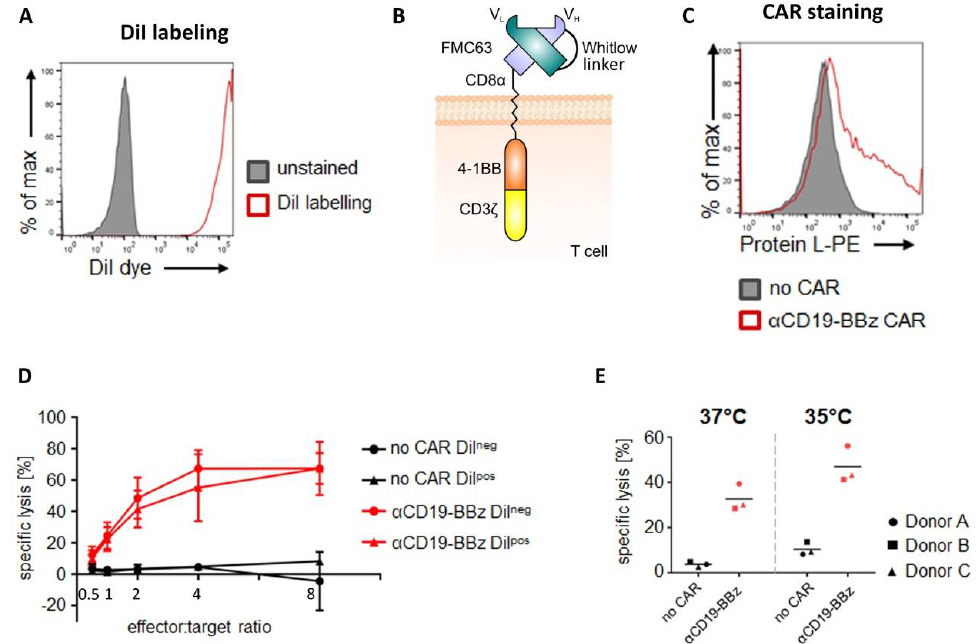
Figure 1. Chimeric antigen receptor (CAR) T cell mediated killing of Nalm-6 cells in vitro . ( A ) Efficacy of DiI-labeling in primary human T cells was analyzed by flow cytometry (excitation at 561 nm, detection with a 582/15 bandpass filter). Unlabeled T cells (“unstained”; filled grey histogram) served as a control. One representative experiment is shown. ( B ) Schematic of the CD19-specific second-generation CAR (FMC63.4-1BB.ζ) in which the FMC63-based scFv was fused to the hinge and transmembrane region of CD8α and the cytoplasmic domains of 4-1BB and CD3ζ. ( C ) Expression of the CD19-specific CAR in primary human T cells. Flow cytometric analysis using Protein L as a detection reagent. Mock T cells (“no CAR”; filled grey histogram) served as a negative control. One representative experiment of three independent experiments is shown. ( D ) Influence of DiI-labeling on the cytolytic activity of CAR T cells. Primary human T cells expressing either the CD19-specific CAR or no CAR and labeled or not labeled with DiI were co-cultured with CD19 pos Nalm-6 cells. Experiments were performed with E/T (effector/target) ratios of 0.5, 1, 2, 4, and 8, as indicated. Cytolytic activity was quantified using a luciferase-based cytotoxicity assay. Data are expressed as means ± SD of one experiment with three donors. ( E ) Influence of the temperature on the cytolytic activity of CAR T cells. Primary human T cells expressing either the CD19-specific CAR or no CAR were co-cultured at 35 °C or 37 °C with GFP pos /CD19 pos Nalm-6 cells at an E/T ratio of 1:1. Cytolytic activity was quantified by using a counting bead-based cytotoxicity assay. Data are expressed as individual data points (and their means) obtained from one experiment with three different T cell donors.